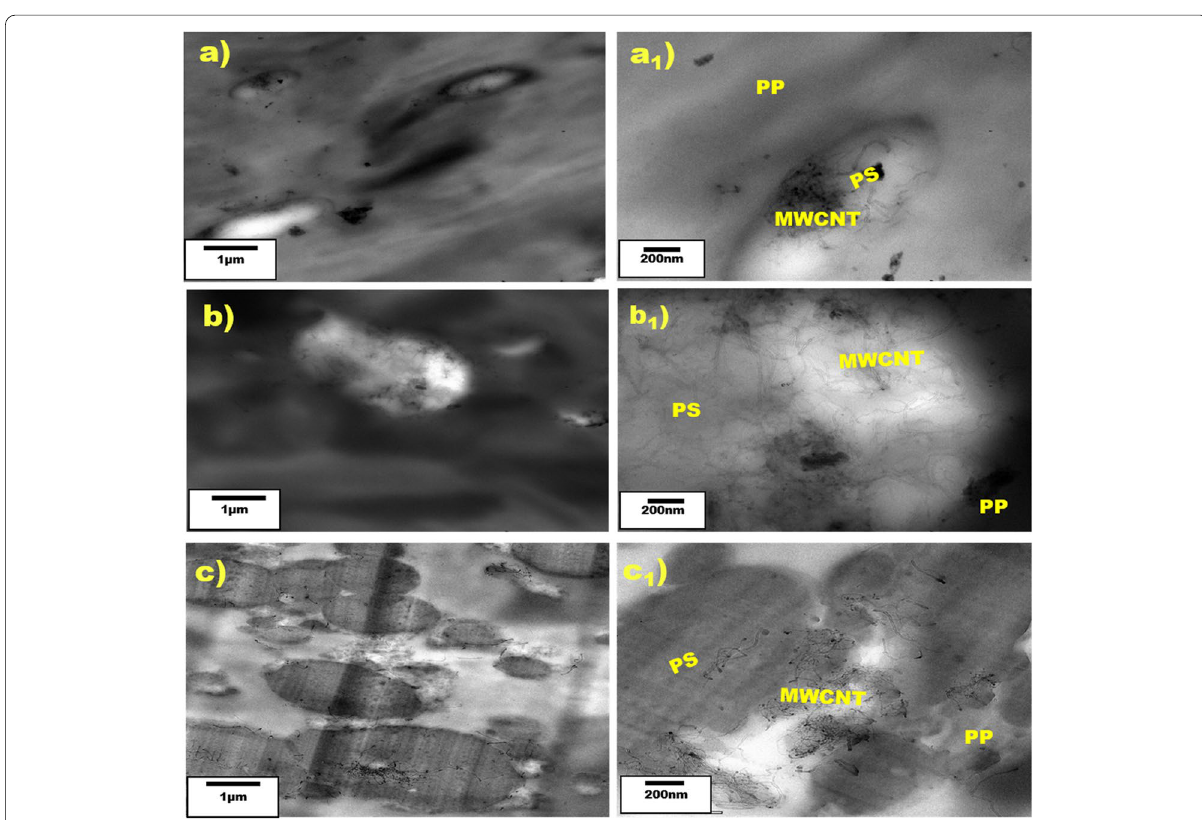
Fig. 2 TEM Images of 2 vol% MWCNT and 5 vol% copolymer a-a 1 ) PP/PS 80:20 b-b 1 ) PP/PS 80:20/SEBS-A1535 HU, c-c 1 ) PP/PS 80:20/SEPs-